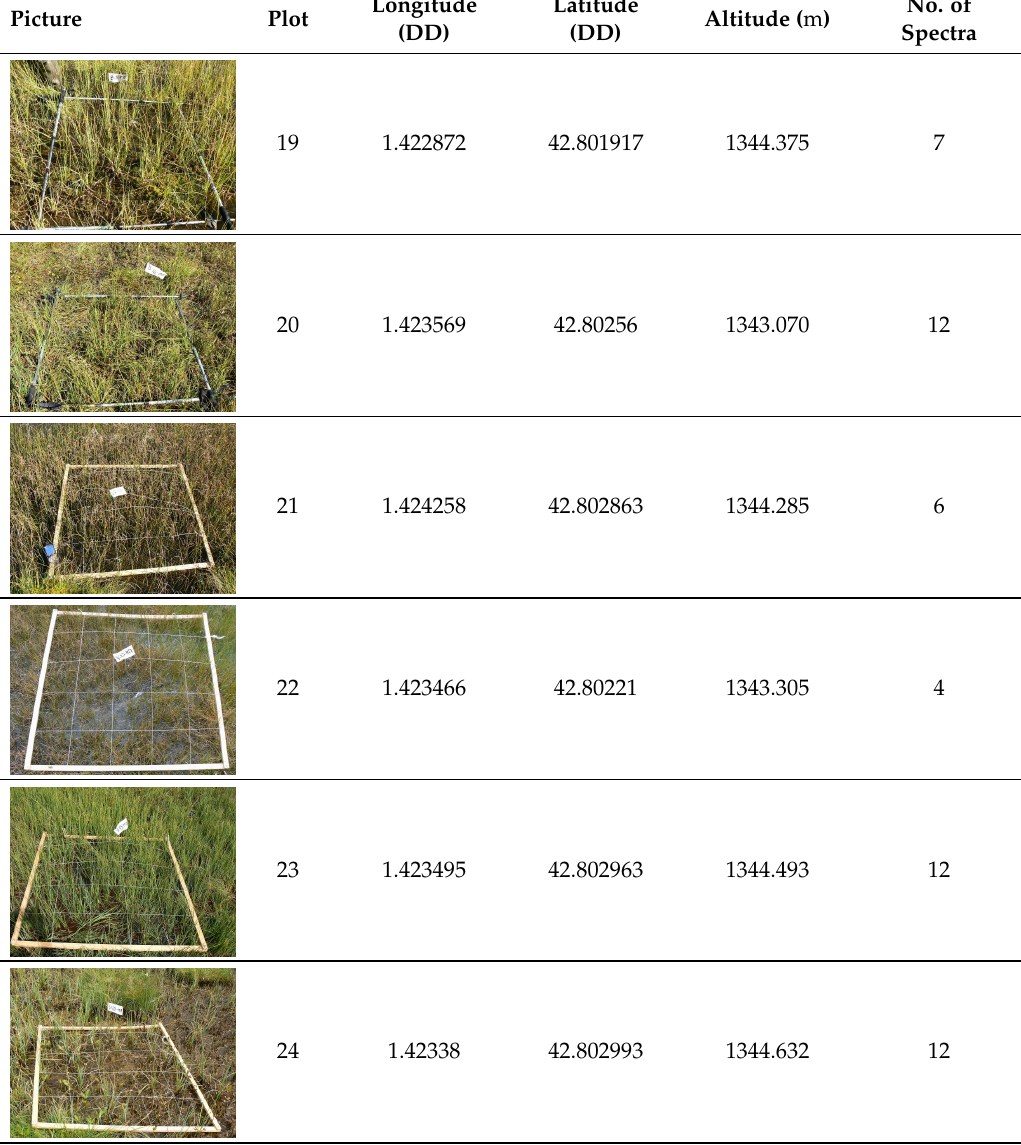
Table A10. Pictures, plots, geographic coordinates and number of spectra of Aquatic type a (AQ_A). Picture